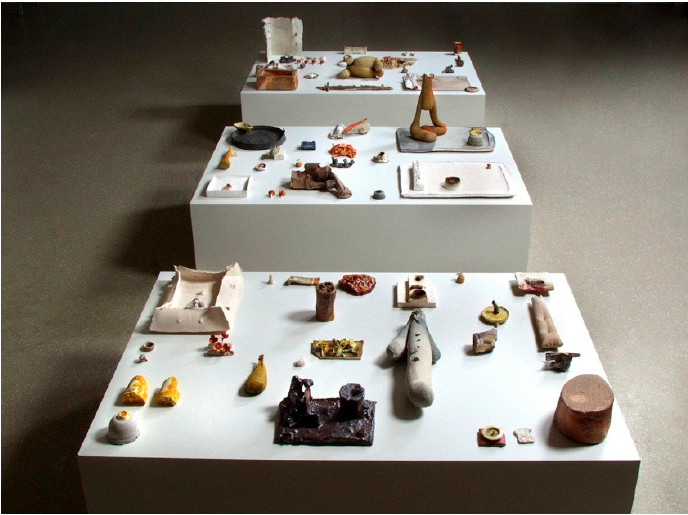
Figure 11. Brownsword. 2001. SY Series .